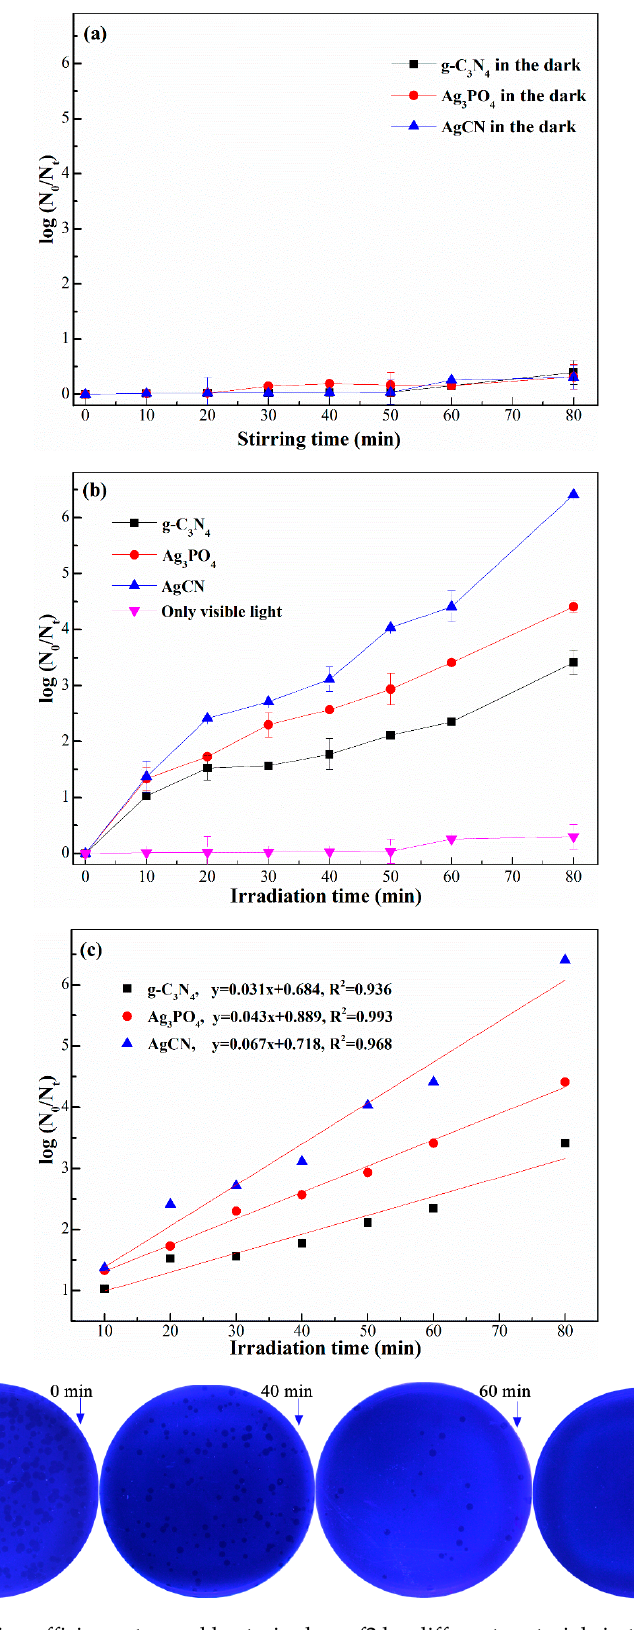
Figure 6. Inactivation efficiency toward bacteriophage f2 by different materials in the dark ( a ); under visible light irradiation ( b ); linear fitting of the kinetic curves of inactivation ( c ); and images of counting plate at different times ( d ).